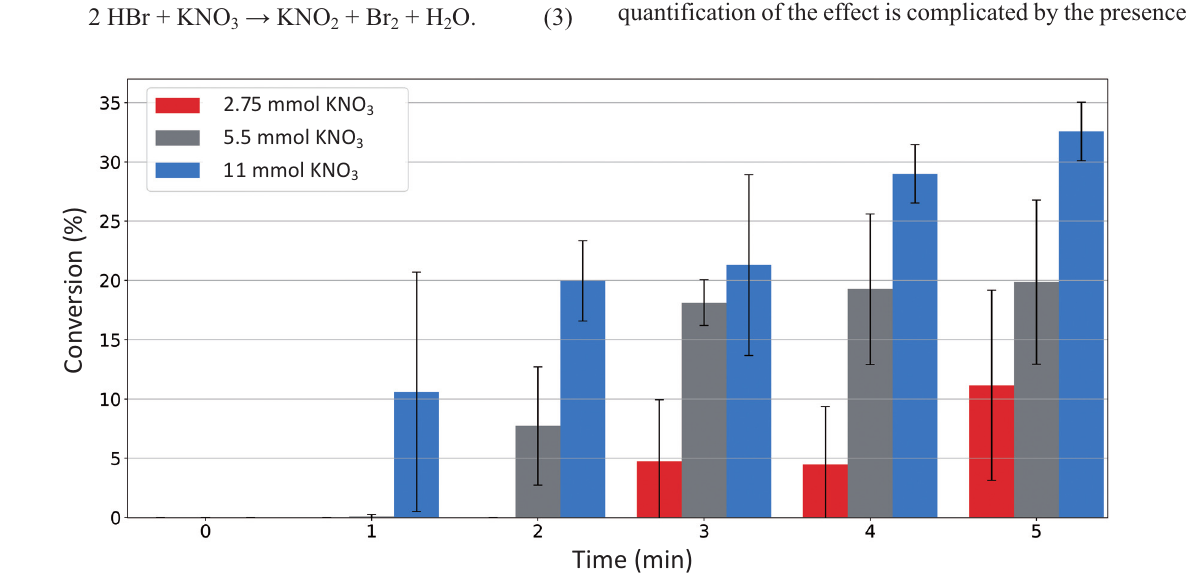
Fig. 1. Results of acetanilide oxidative bromination in the reaction system, containing different amounts of KNO 3 (2.75, 5.5 or 11 mmol), 5 mmol of acetanilide and at continuous flow of gaseous HBr. The error bars were calculated from triplicate